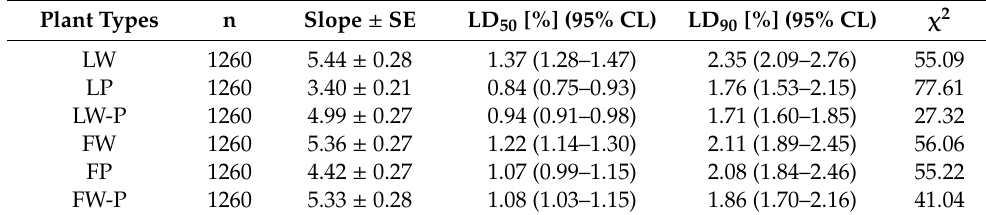
Table 4. Lethal doses, LD 50 and LD 90 of six types of essential oils of A. conyzoides against adult, female Ae.